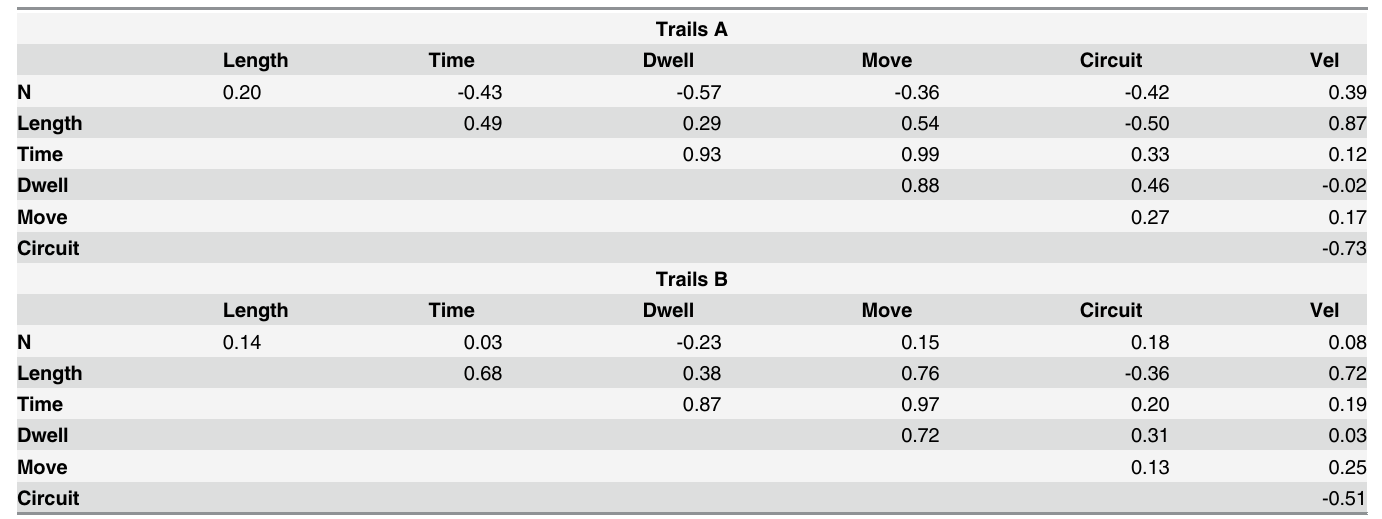
Table 3. Pearson correlations between segment parameters and performance measures.